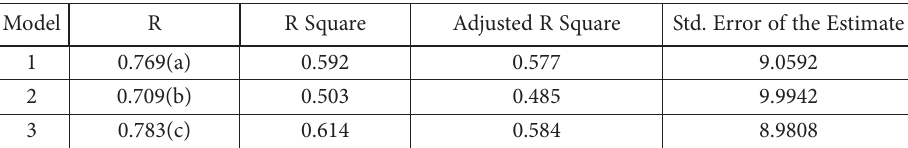
Table 1. Model summary (pillars)